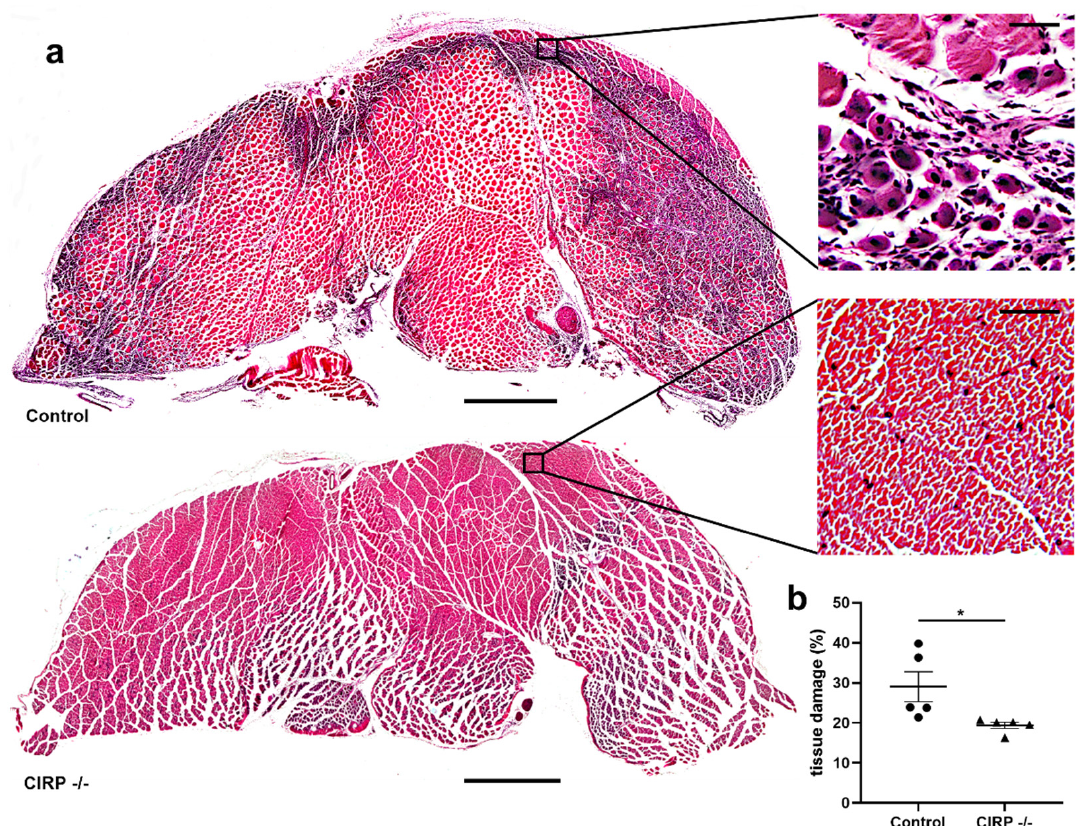
Figure 1. Cold-inducible RNA-binding protein (CIRP) knockout mitigates ischemic tissue damage. ( a ) Representative pictures of Hematoxylin and Eosin stained gastrocnemius muscle slices of control (above) and CIRP -/- (below) mice 7 days after femoral artery ligation (FAL). Right: Magnification of the areas indicated by the black square. Regenerating muscle cells showing centralized nuclei are a sign of ischemic muscle damage. Scale bars 1000 µm (overview) and 50 µm (detail). ( b ) The scatter plot displays the percentage of tissue damage in relation to the whole gastrocnemius muscle of control and CIRP -/- mice 7 days after FAL. The total gastrocnemius cross-sectional area (about 20 mm 2 ) was analyzed. Data are means ± S.E.M., n = 5 per group, * p < 0.05 (CIRP -/- vs. control) by unpaired, two-sided student’s t-test.